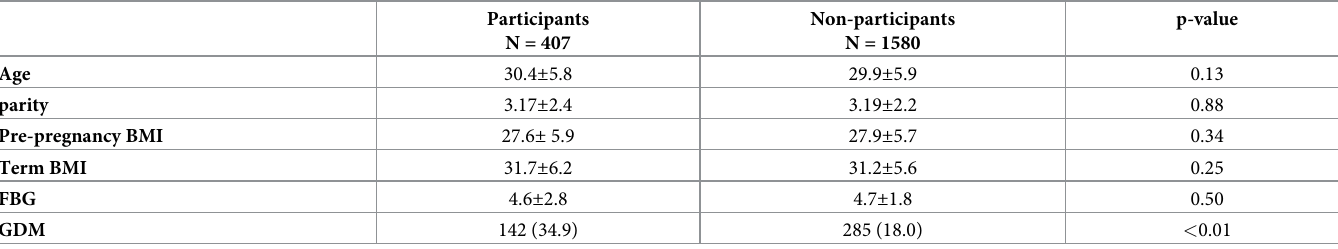
Table 1. Comparison of characteristics of women who participated and those did not participate in the